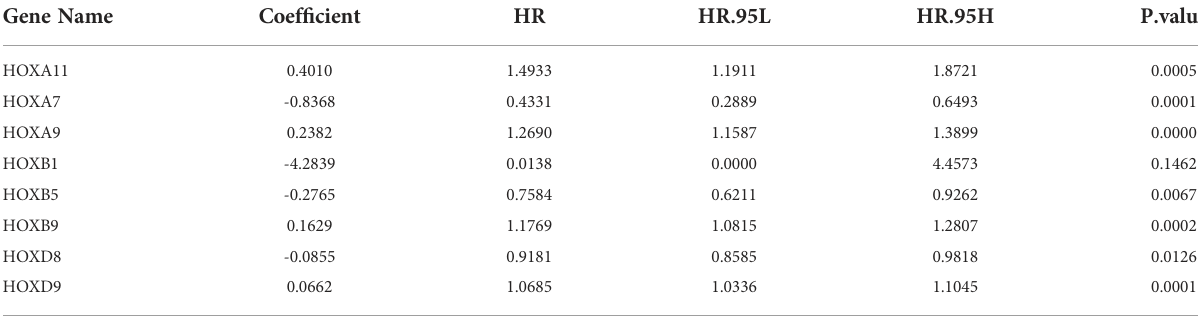
TABLE 1 Overall information of nine-HOXs constructing the prognostic